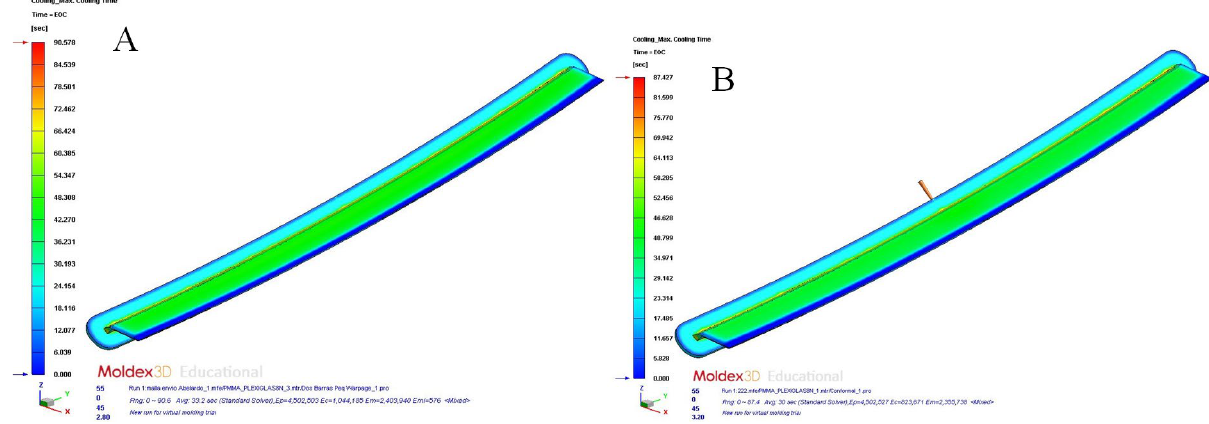
Figure 14. Maximum cooling time (s); conformal channels—dashed Fastcool bars ( A ), conformal channels ( B ).